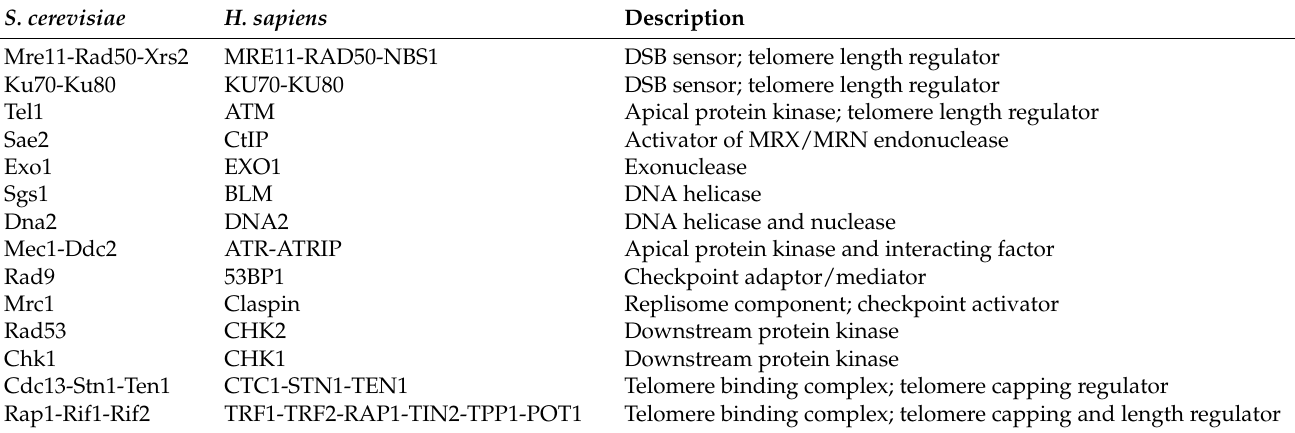
Table 1. Major proteins involved in the DNA damage response and telomere